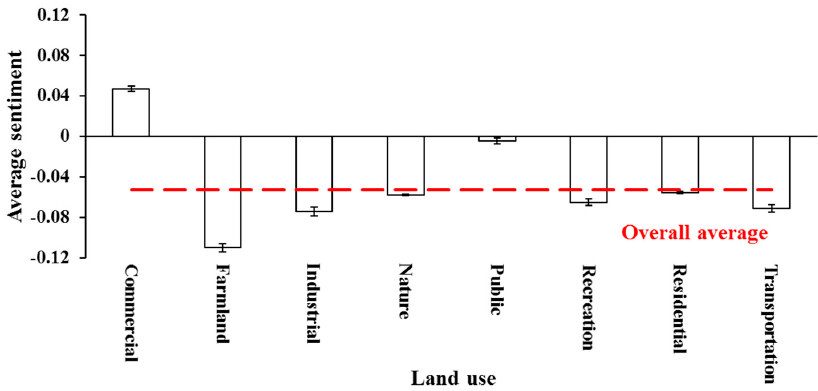
Figure 3. Average sentiment scores by land use categories.